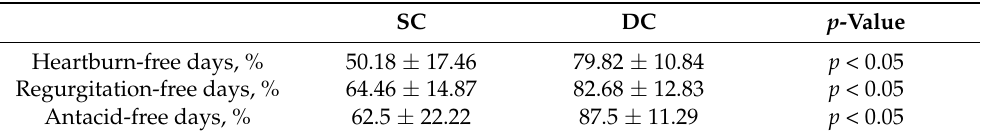
Table 4. Symptoms and Antacid-Free Days during SC and DC Treatment Periods. Data are presented as percentages (%).